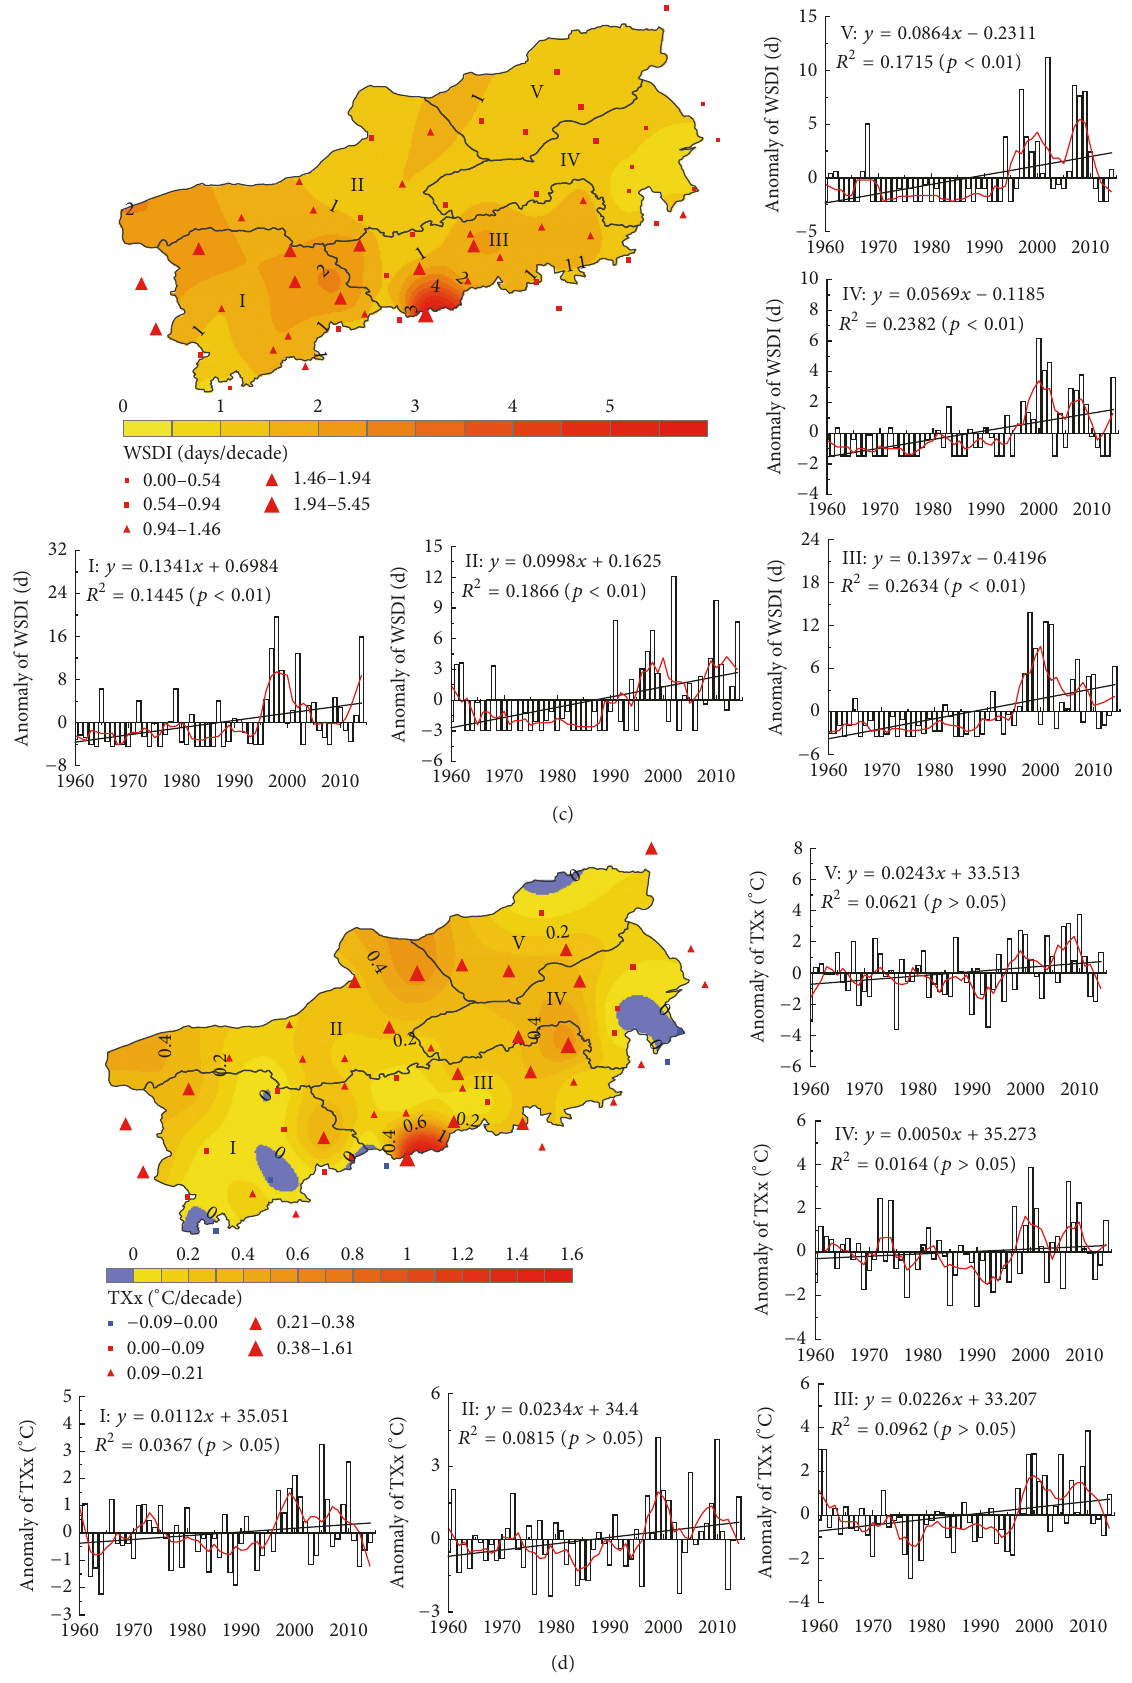
Figure10:Spatialpatternsofthetrendslopesofwarm-relatedindicesacrosstheBTSSRandanomalyofsubregionalindicescurves,1960–2014. The black line represents the linear trends for (a) TN90p, (b) TX90p, (c) WSDI, and (d) TXx. The redline represents the 5-year moving